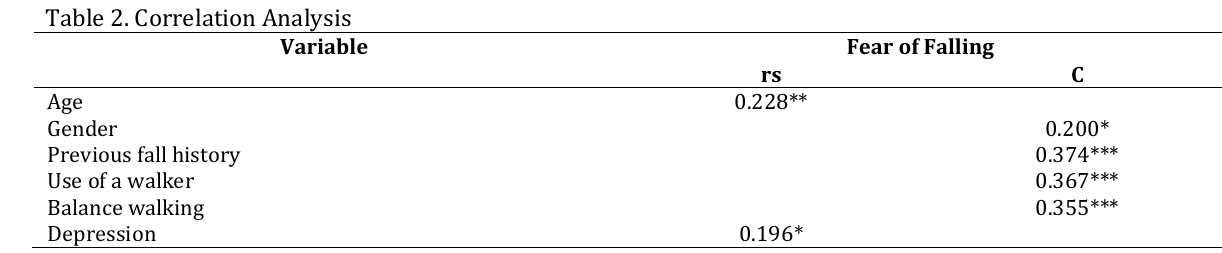
Table 2. Correlation Analysis